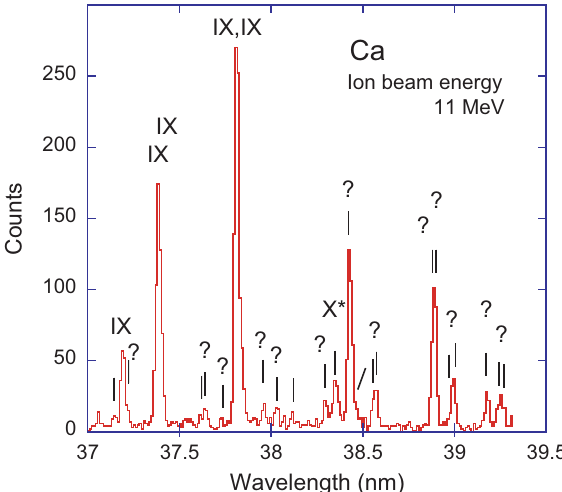
Figure 5. Spectrum of Ca near the most prominent line of the doubly excited spectrum CaX*. Fiducial markers indicate a multitude of unidentified Ca lines. Line width